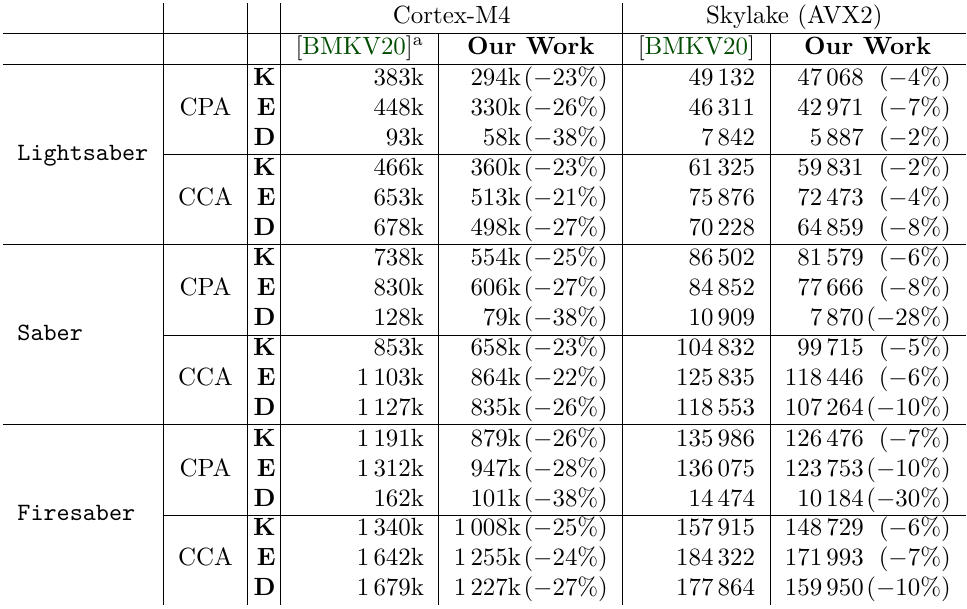
Table 6: Performance results in clock cycles for Lightsaber , Saber , and Firesaber